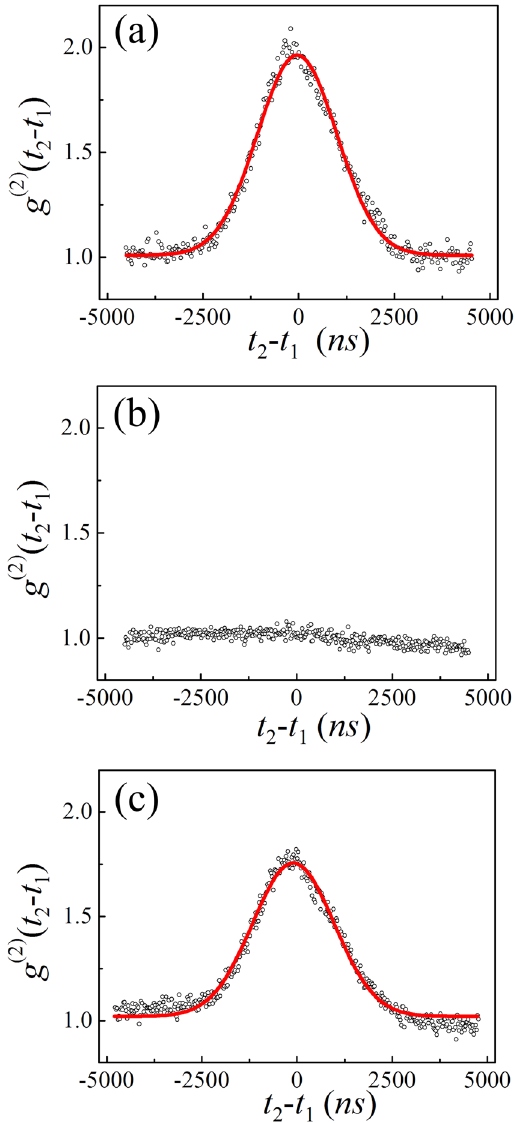
Figure 2. The results of temporal HBT effect. ( a ) Is the measured result in Step I. The visibility of the peak is about 31.5%. ( b ) Is the measured result in Step II. No HBT effect can be observed. ( c ) Is the measured result in Step III. The HBT effect is observed and its FWHM is 2520 ns. The visibility of the peak is